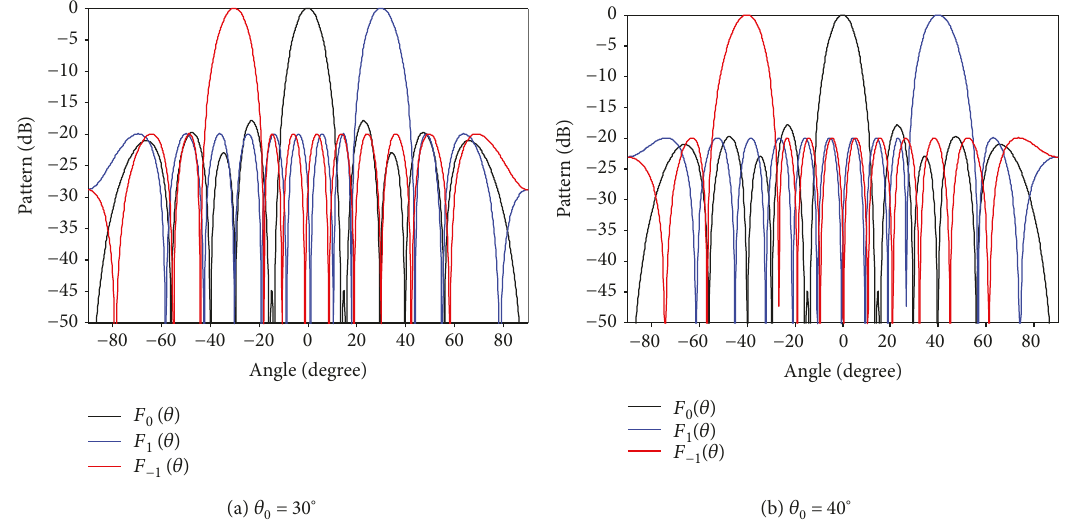
Figure 3: Rational patterns obtained by Chebyshev